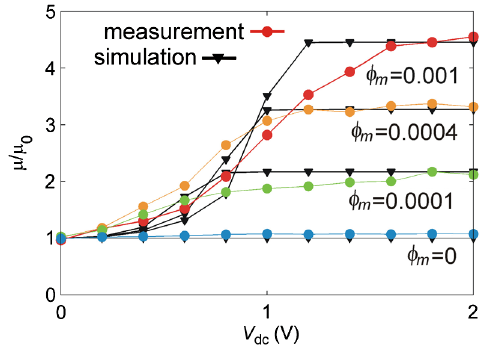
FIG. 6. The equilibrium mobility (cid:1) 0 is the mobility measured in absence of a dc voltage. Without surfactant ( (cid:2) m ¼ 0 ) the mobility is on average very small, but some particles (as in this case) get a larger charge after contact with a charged electrode. When surfactant is present, the mobility is about (cid:1) 210 (cid:1) m V (cid:1) 1 s (cid:1) 1 and is practically independent of the surfac- tant concentration.